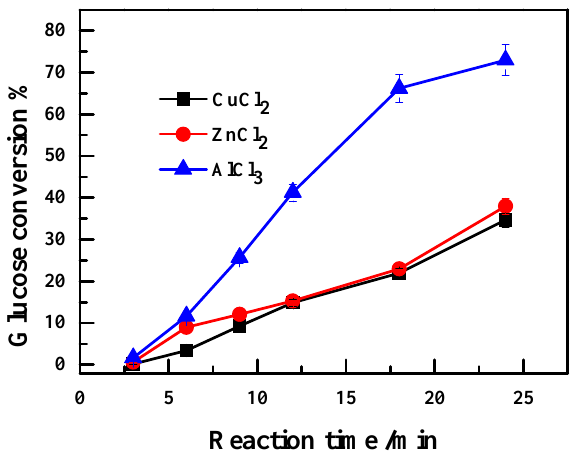
Figure 3. Effect of ionic radii of Lewis acid salts on the conversion of glucose. Reaction conditions: reaction temperature of 160 °C, reaction time of 25 min, 0.1 g glucose in 1.5 g 25 mM Lewis acids aqueous solution, 3 g sec-butyl phenol.